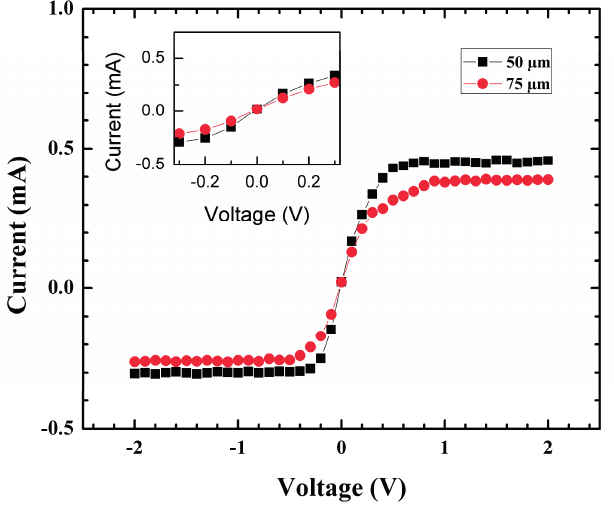
Figure 8. I-V curve of 37 mm SBSPD with 50 μ m and 75 μ m spacing between doped lines. Inset from − 0.3 to 0.3 shows the resistance changes when varying the distance between doped